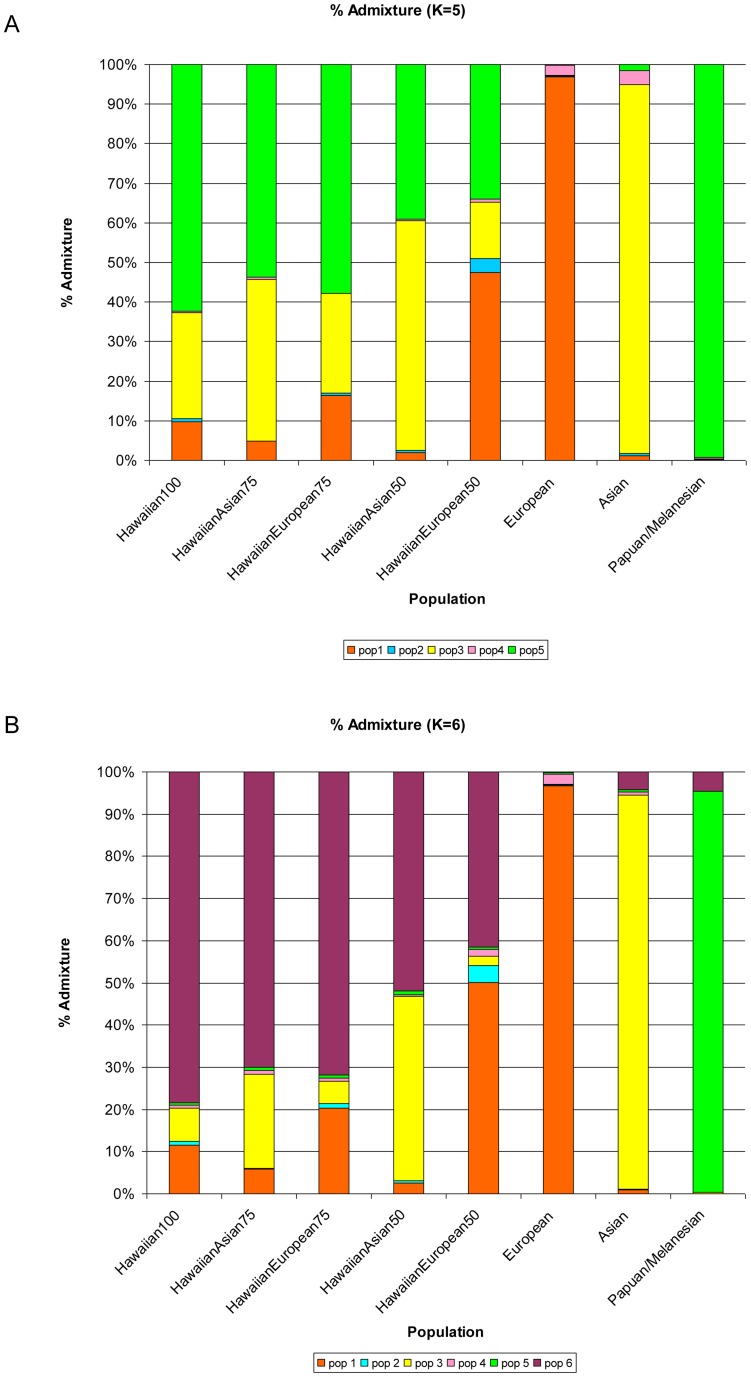
Average of each ancestral clustering estimated by ADMIXTURE for K = 5 and K = 6.
Figures 2A and 2B illustrate the mean values for each proportion of ancestry based on GWAS data. Pop1-6 are the ancestral populations representing the European, African, East Asian, American, Oceanian, and Hawaiian populations, respectively.